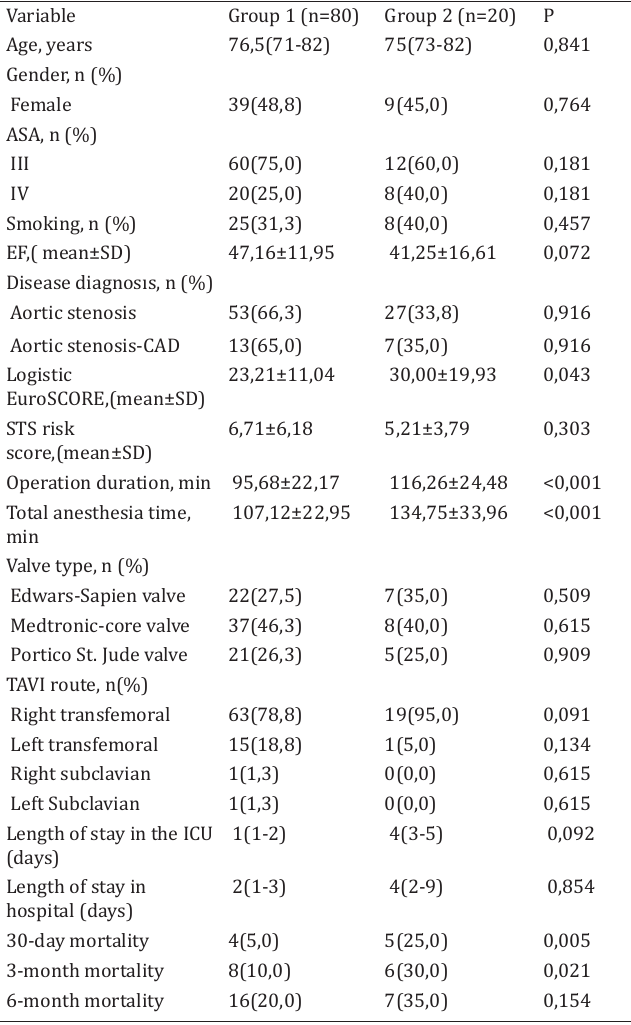
Patients’ demographic